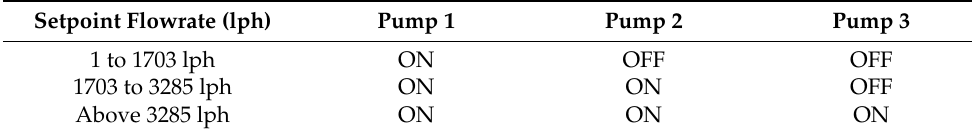
Table 2. Pump setpoint flowrates in cascade pump control.